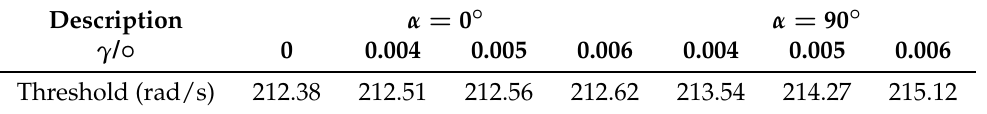
Table 6. Threshold for various misaligned